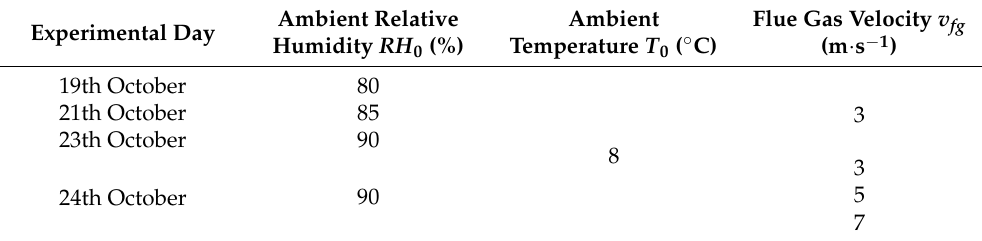
Table 2. Experimental design.